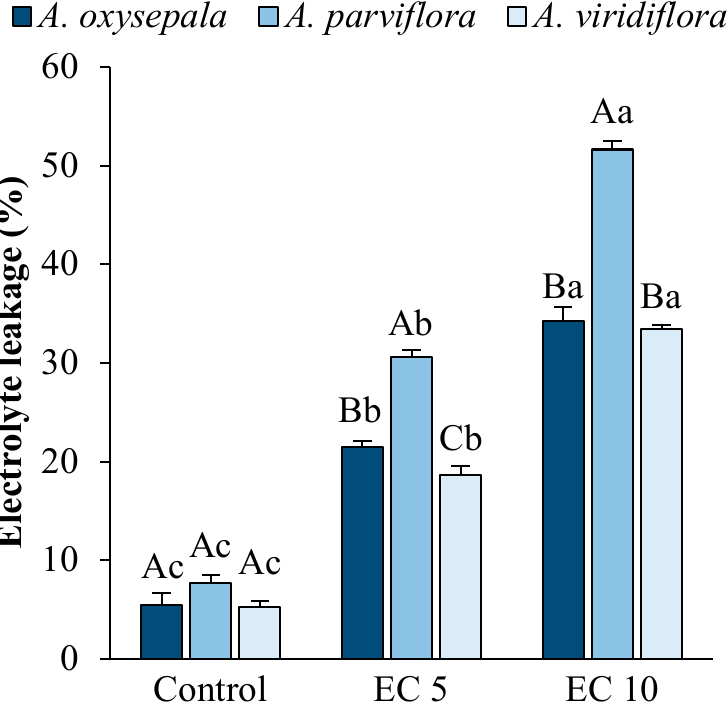
Figure 5. Electrolyte leakage of A. oxysepala , A. parviflora , and A. viridiflora irrigated with tap water (control) and salt solution at an electrical conductivity (EC) of 5 dS · m − 1 (EC 5) and 10 dS · m − 1 (EC 10). According to Tukey’s variance and analysis at p < 0.05, means with the same uppercase letters are not significantly changed among different species under the same treatment, and means with the same lowercase letters are not significantly changed among different treatments in the same species. Vertical bars represent standard error (SE).